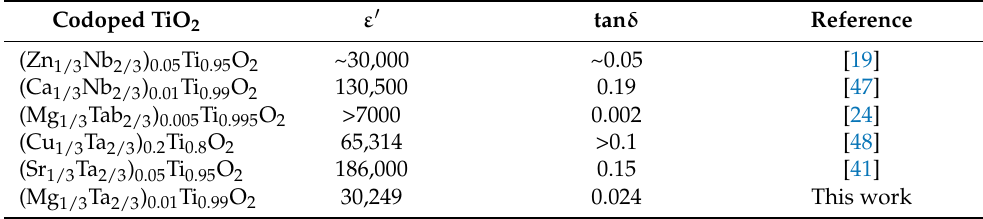
Figure 4. ( a ) Temperature dependence of ε′ for as-MTTO and annealed MTTO ceramics at 1 kHz; the inset shows the temperature dependence of the tan δ of the as-MTTO and annealed MTTO ceramics at 1 kHz. ( b ) Temperature coefficient of ε′ at 1 kHz for as-MTTO and annealed MTTO ceramics. ( c ) Frequency dependence of ε′ at RT under different DC voltage biases for the annealed MTTO ceramic. ( d ) DC bias voltage dependence of ε′ at 10 3 and 10 4 Hz for the annealed MTTO ceramic. Table 2. ε (cid:48) and tan δ at 1 kHz and room temperature of +2/+5 ions codoped TiO 2